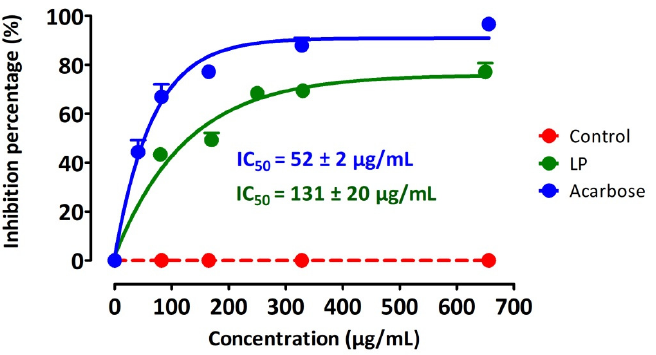
Figure 5. Inhibiting effect of the LP aqueous extract and acarbose on the intestinal α -glucosidase enzyme activity. Arcabose (medicine) was used as positive control.